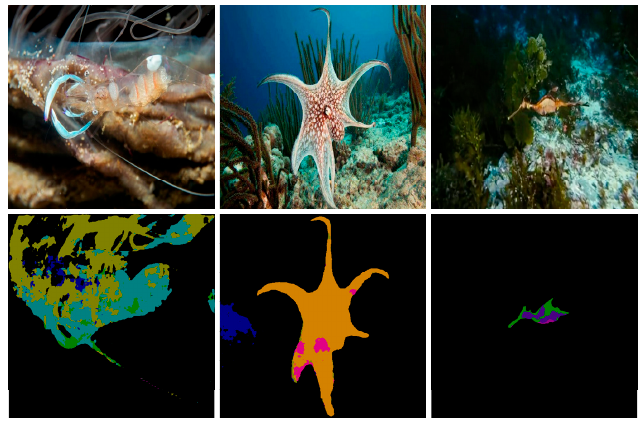
Figure 9. Failure cases.